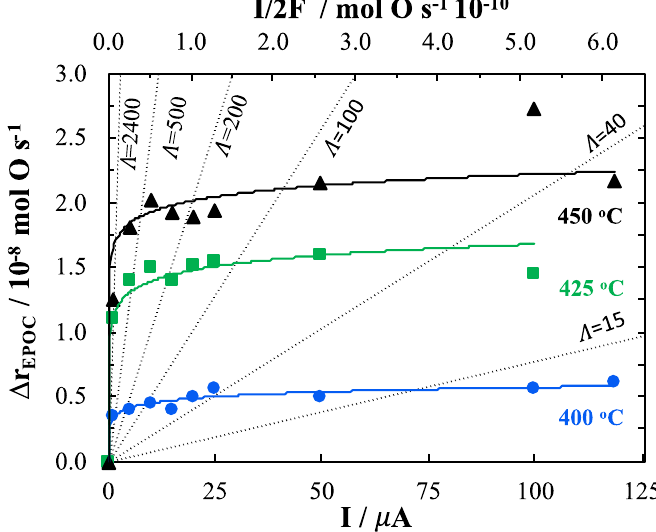
Figure 10. Current effect on catalytic rate in function of temperature: 400, 425 and 450 °C. P CH4 = 2 kPa and P O2 = 4 kPa. Flow rate: 100 ccm.